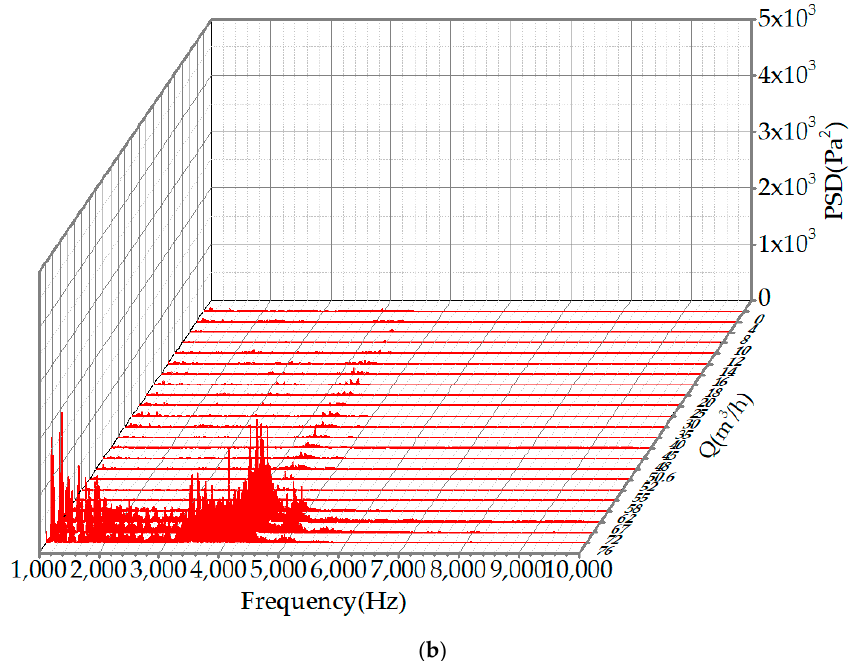
Figure 14. Power spectral density (PSD) of the acoustic pressure measured by pump inlet hydrophone 1 at different flow rates. ( a ) 0–300 Hz; ( b ) 1–10 kHz.